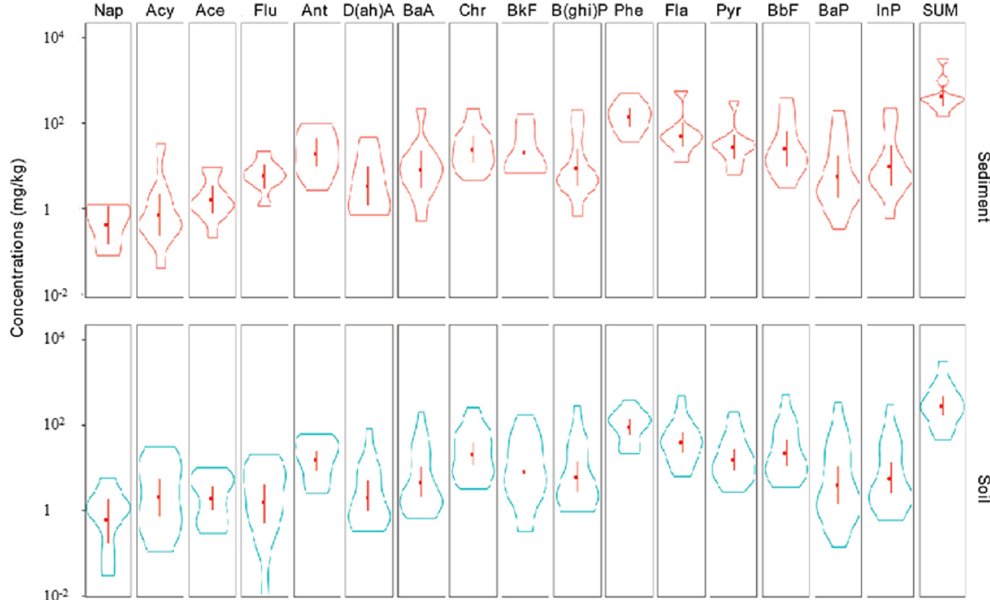
Figure 2. Violin plot charts of PAHs concentrations in surface soils and sediments of Poyang Lake. Note: the violin plots reflect the probability density of distribution, with the bottom and top vertical lines in boxes representing the 25th and 75th centiles, respectively. Red frame reflect PAHs in sediment, blue frame reflect PAHs in soil.